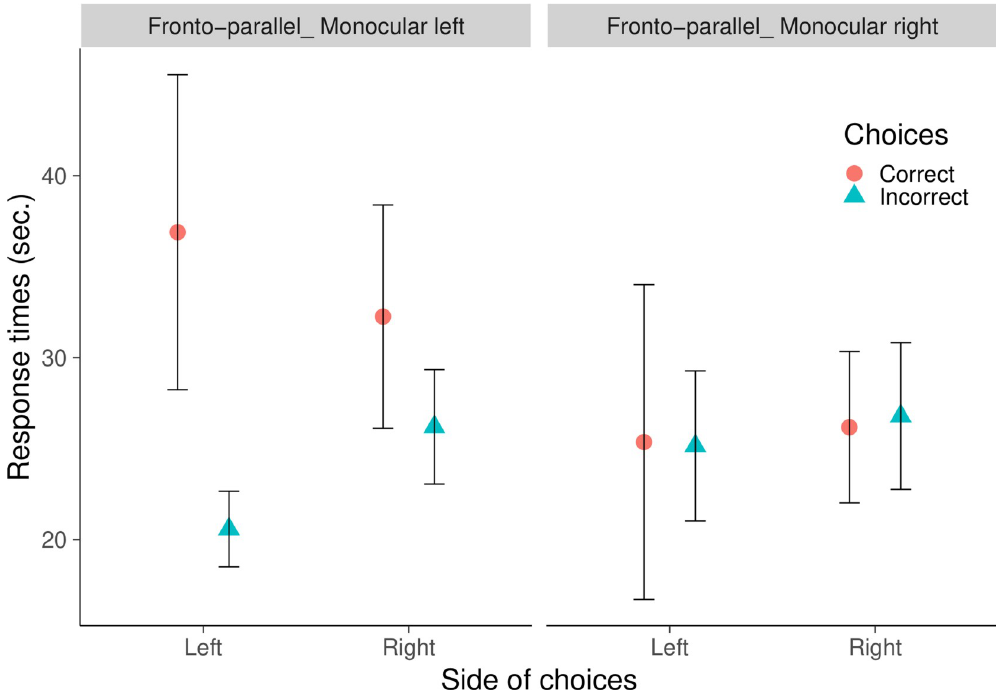
Fig 4. Direction of approach in the monocular fronto-parallel tests. The graphs represent the mean percentage + SE of direction of approach for left, central and right choices, respectively. Results of the left monocular fronto-parallel test, in red; results of the right monocular fronto-parallel test, in